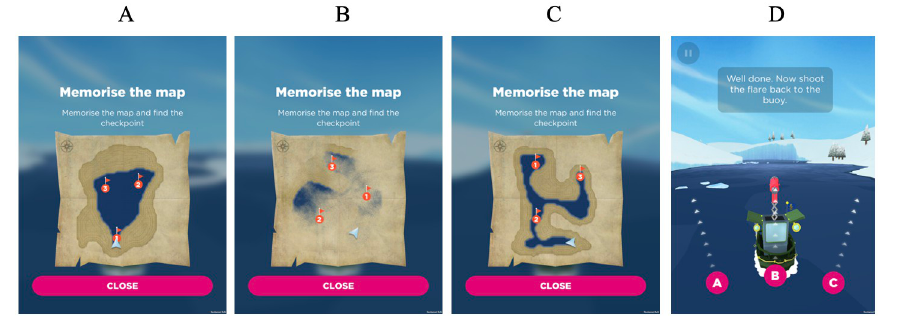
Fig 2. Sea Hero Quest visual examples of wayfinding and path integration levels. Wayfinding levels 6, 8 and 11 presented in A, B, and C respectively. Path integration level 4 is presented in D.